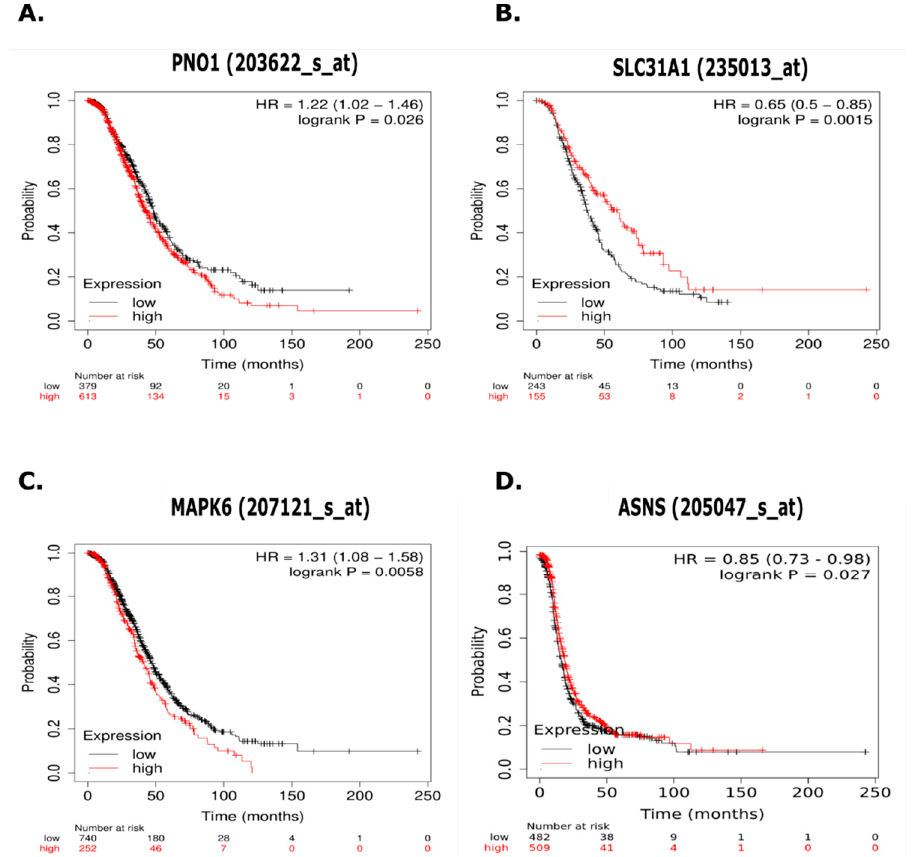
Figure 6. Kaplan Meier (KM) plots measuring progression free survival (PFS) in serous ovarian cancer patients treated with platinum-based chemotherapy ( n = 979) related to selected proteins. ( A ) RNA binding protein PNO1 ( PNO1 ) showed abundance at least 1.5-fold lower in parental cell lines and is associated with significantly decreased PFS. ( B ) High affinity copper uptake protein ( SLC31A1 ) showed abundance at least 1.5-fold higher in parental cell lines and is associated with significantly increased PFS. ( C ) Mitogen-activated protein kinase 6 ( MAPK6) showed abundance at least 1.5-lower in parental cell lines and is associated with significantly decreased PFS. ( D ) Asparagine synthase (ASNS) showed abundance at least 1.5-fold higher in OVCAR-5 parental cells, is part of the enriched Alanine, Aspartate and Glutamate Metabolism pathway, and is associated with significantly increased PFS.